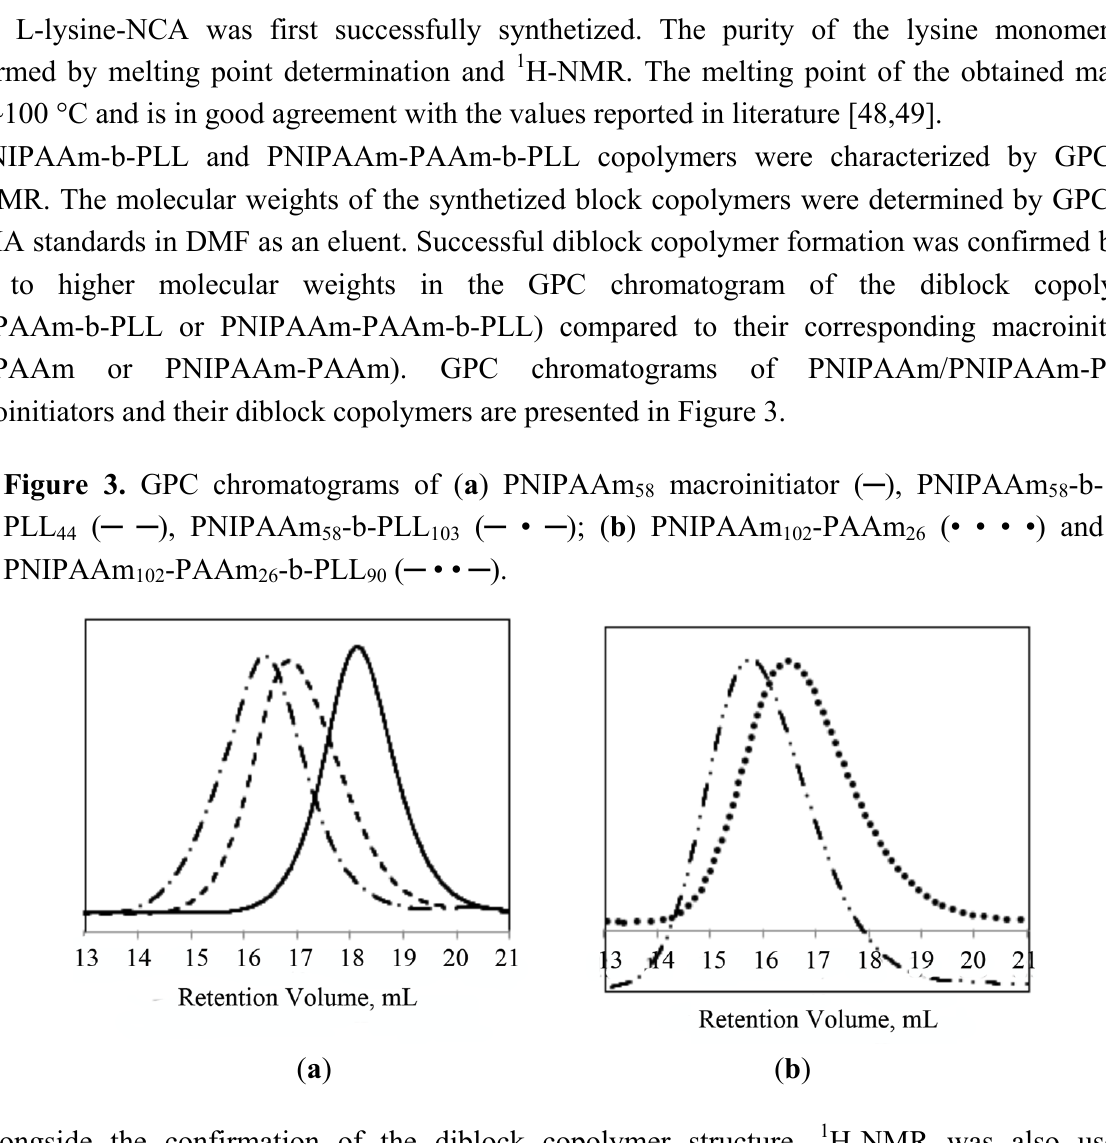
Figure 3. GPC chromatograms of ( a ) PNIPAAm